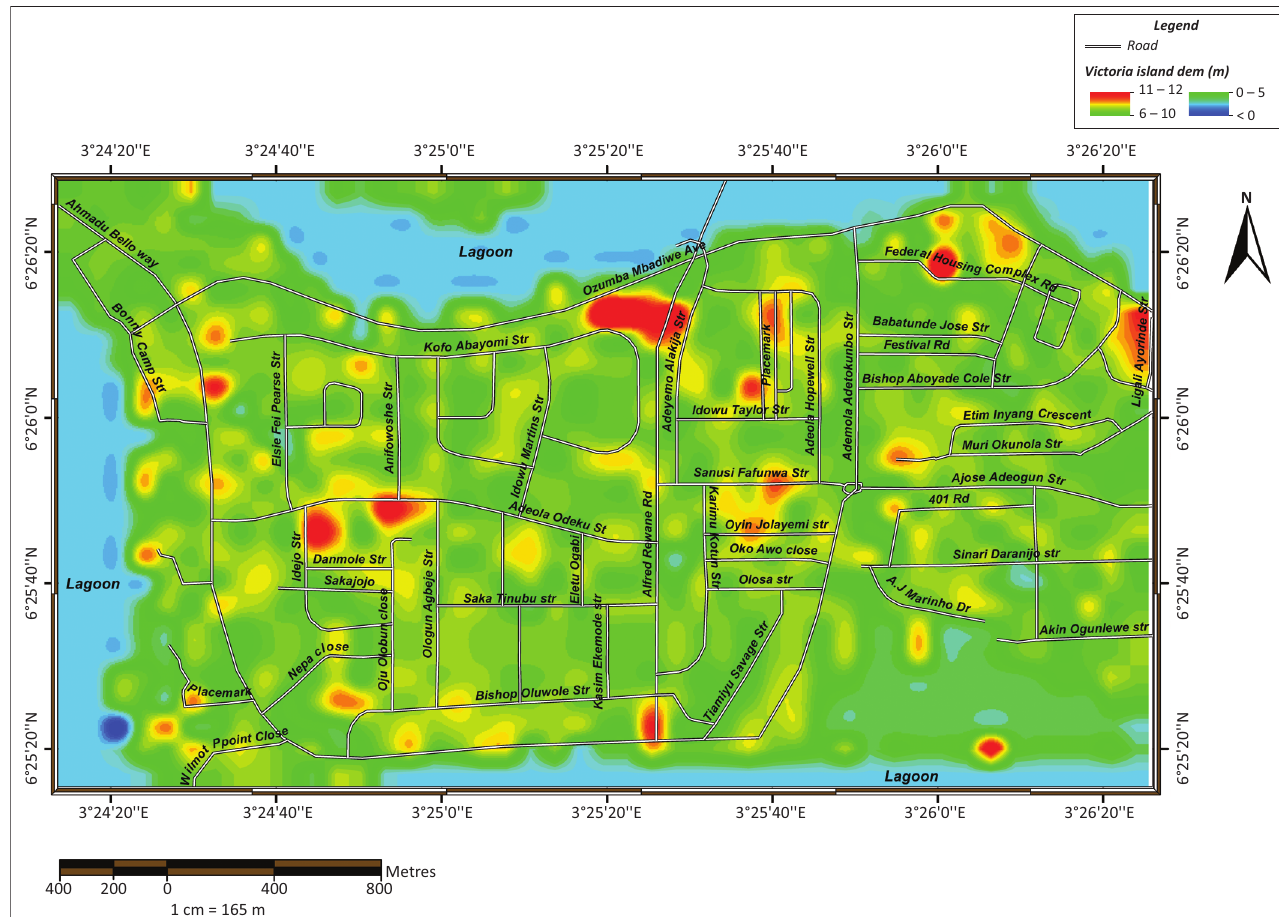
m, metre; DEM, Digital Elevation Model. FIGURE 4: Elevation analysis of Victoria